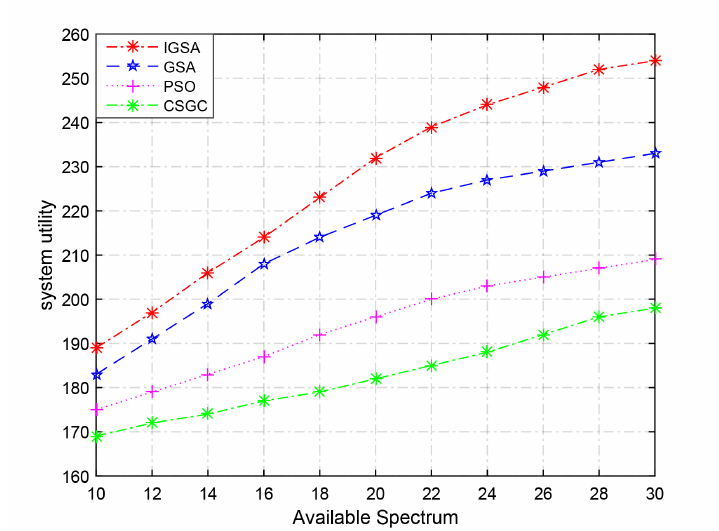
Figure 6. The system utility trend when N =